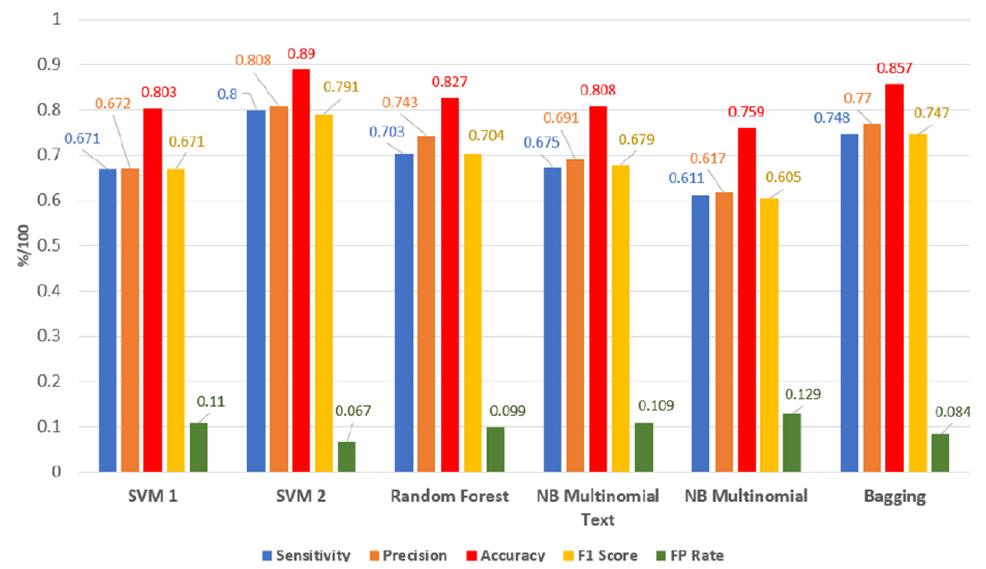
Figure 9. The average results of all models in Sensitivity, Precision, Accuracy, F1 Score and FP Rate measures. Table 12. Comparison of results in Accuracy of our best model to the best models from previous studies focused on the same respectively similar